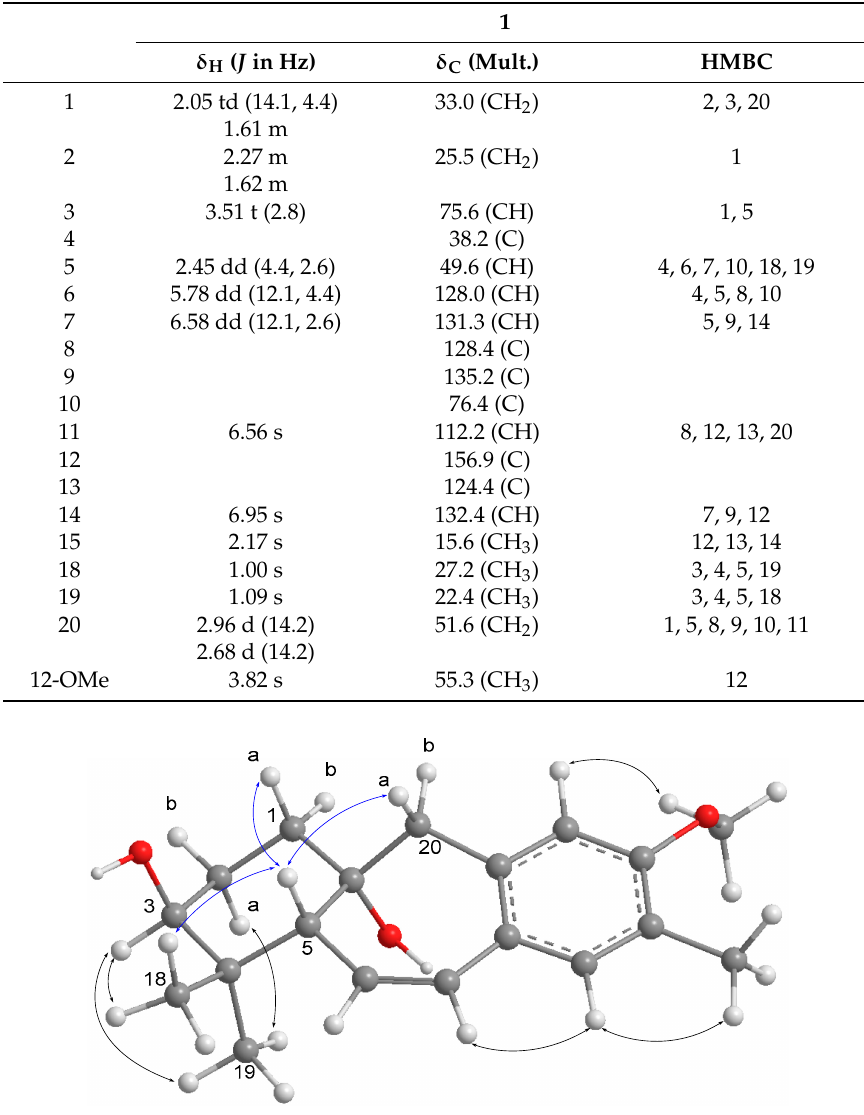
Table 1. 1 H- and 13 C-NMR Spectroscopic Data (400 and 100 MHz, resp.; CDCl 3 ) of 1 .